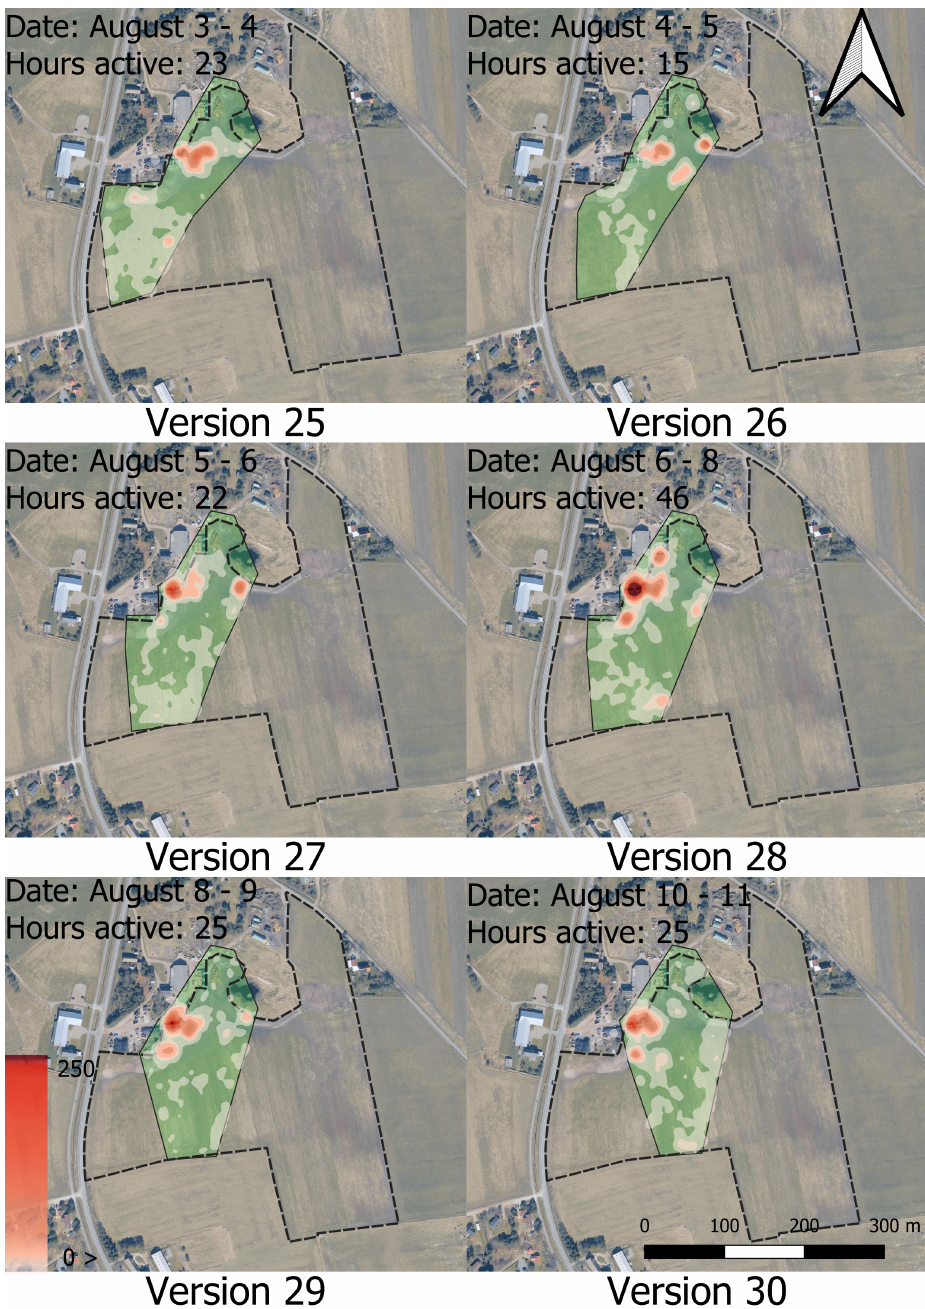
Figure A14. Heatmap series 5 visualising all Poll messages sent during the period from 3 August to 11 August. The green area shows the virtual enclosure area to which the bull calves were limited. The white to red colour indicates the number of Poll messages within a 10 m radius. The brightest colour represents the areas with the lowest density of Poll messages, while the darkest colour represents the areas with 250 or more Poll messages within the radius. The coordinates of the upper left corner of the map frame are 55°25 (cid:48) 23.131 (cid:48)(cid:48) E 8°23 (cid:48) 53.531 (cid:48)(cid:48) N. Contains data from the Agency for Data Supply and Infrastructure, Forårsbilleder Ortofoto-GeoDanmark, December